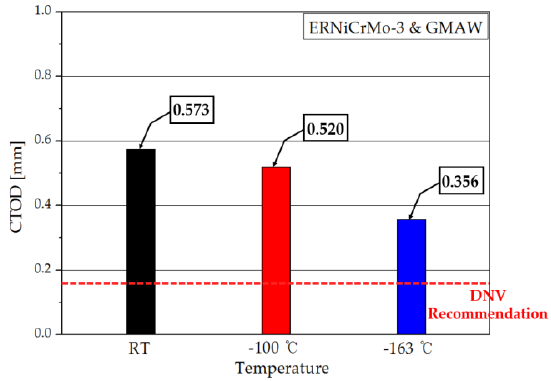
Figure 9. The CTOD values of the HAZ from room to cryogenic temperatures.